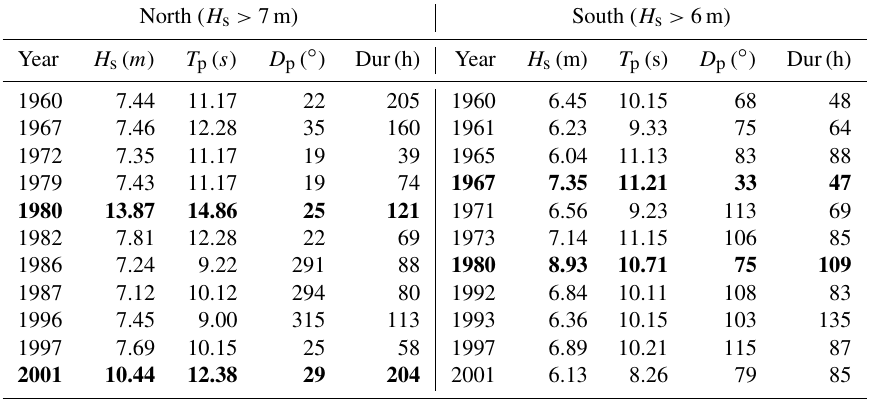
Table 1. Characteristics of the events with maximum significant wave height H s at two grid points north and south of the Balearic Islands, extracted from the HIPOCAS database (Soares et al., 2002). The strongest events are highlighted in bold. North ( H s > 7m) South ( H s > 6m) Year H s (m) T p (s) D p ( ◦ )